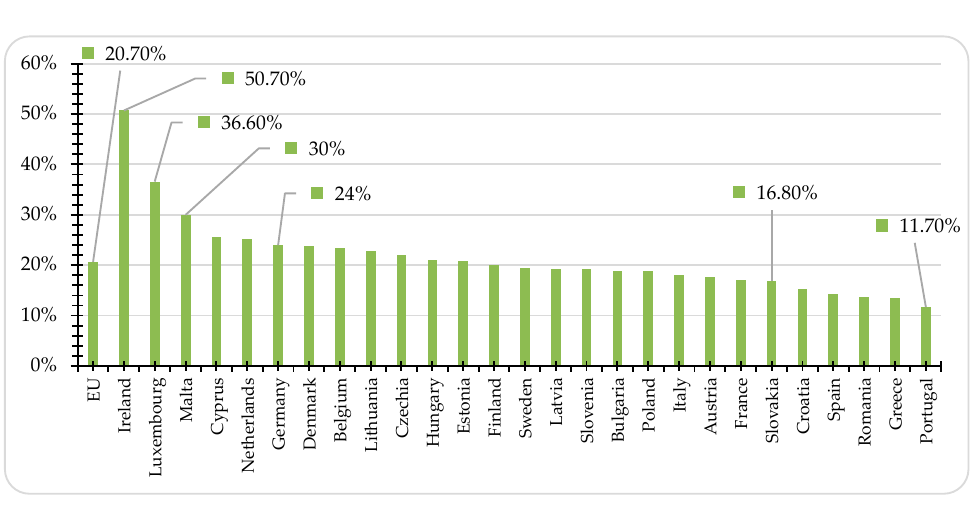
Figure 1. Share of value-added supported by exports . Source: Authors’ compilation according to www.ec.europa.eu (accessed on 4 June 2022).